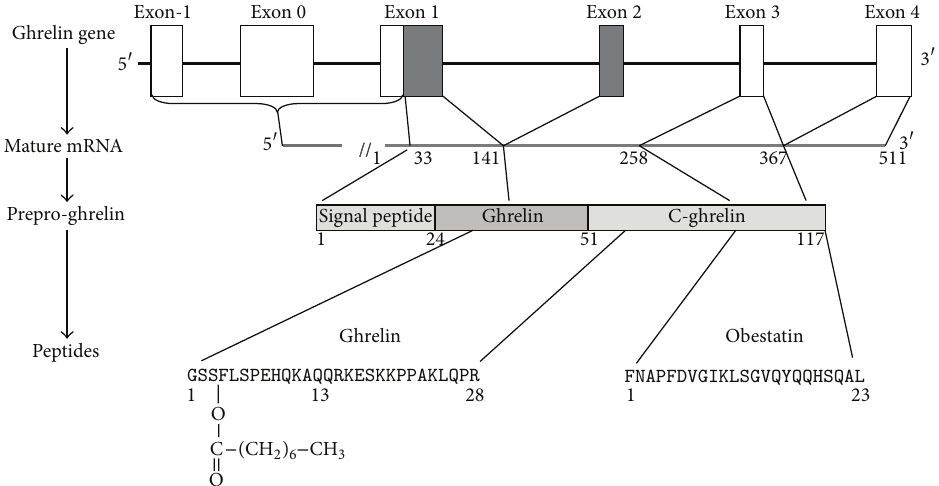
Figure 1: From ghrelin gene to ghrelin peptide. Following the transcription of ghrelin gene containing 2 exons (black boxes) and 5 introns (white boxes), mature ghrelin mRNA is processed into preproghrelin and finally into several peptides, namely, ghrelin and obestatin.